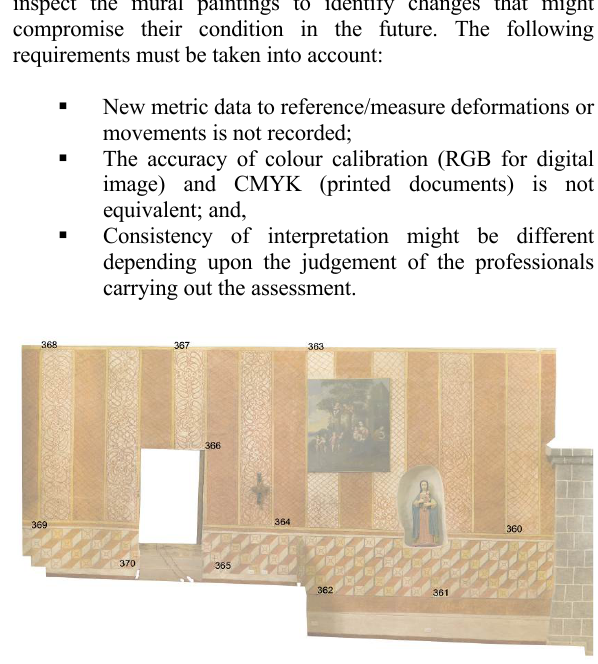
Figure 15 . Ortho-corrected image used as a reference in Scenario 1. Image by CIMS © GCI